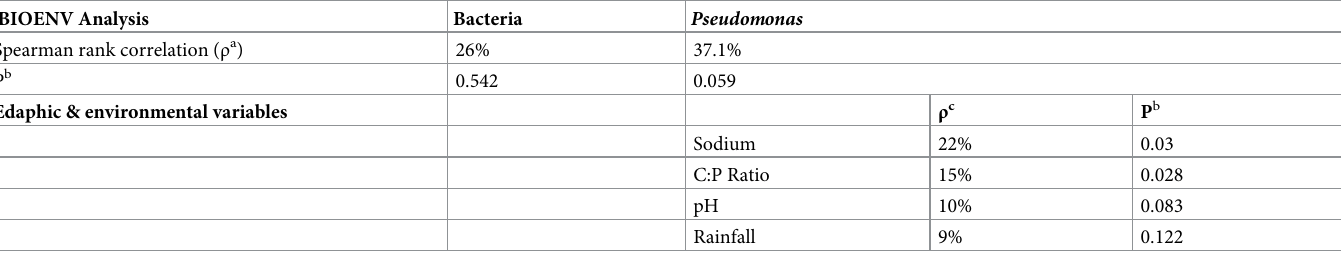
Table 1. Edaphic and environmental properties influencing microbial community